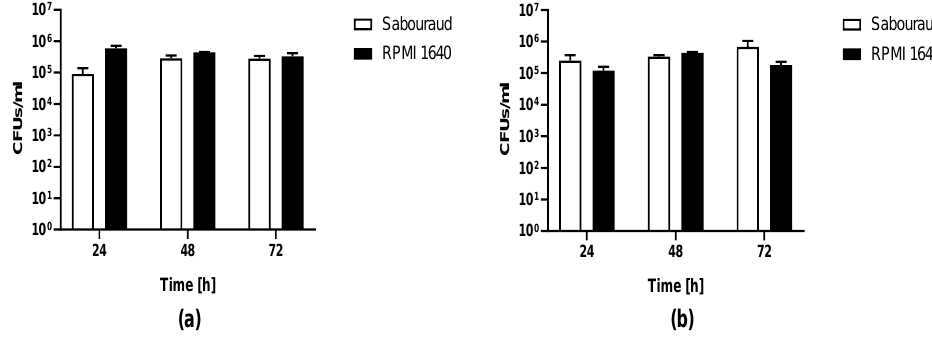
Figure 4. Biofilm of C. auris CBS14916 ( a ) and C. albicans ATCC 90028 ( b ) formed on porous glass beads. CFU number of C. auris and C. albicans dislodged from glass beads by sonication after incubation in either Sabouraud or RPMI 1640 broth at 37 ◦ C for 24, 48, and 72